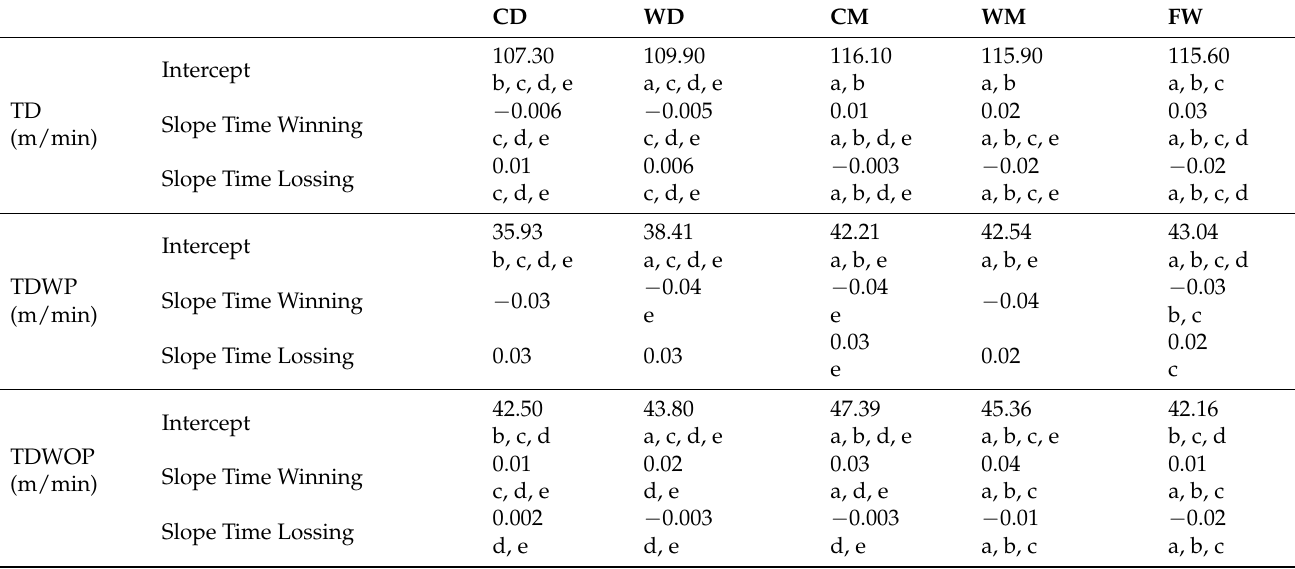
Table 1. Differences by ball possession of position-specific total distance covered according to the scoreline evolution. CD WD CM WM